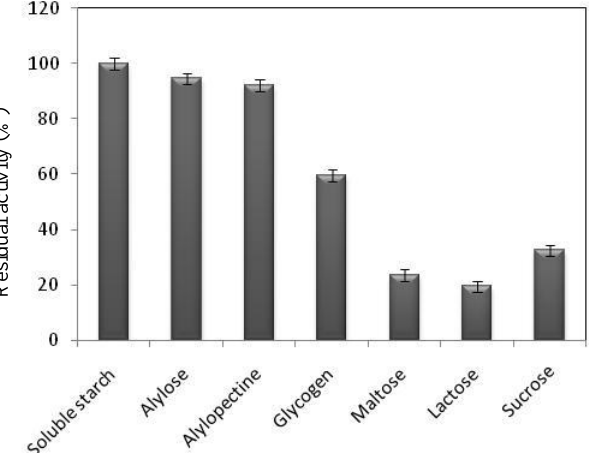
Figure 6. Hydrolysis efficiency of amylase produced by Bacillus pacificus toward different substrates: Starch, alylose, alylopectine, glycogen, sucrose, maltose, and lactose. The different polysaccharides and disaccharides (1 mg/mL) were mixed with pure amylase enzyme and reaction was incubated at 55 °C at pH 9.